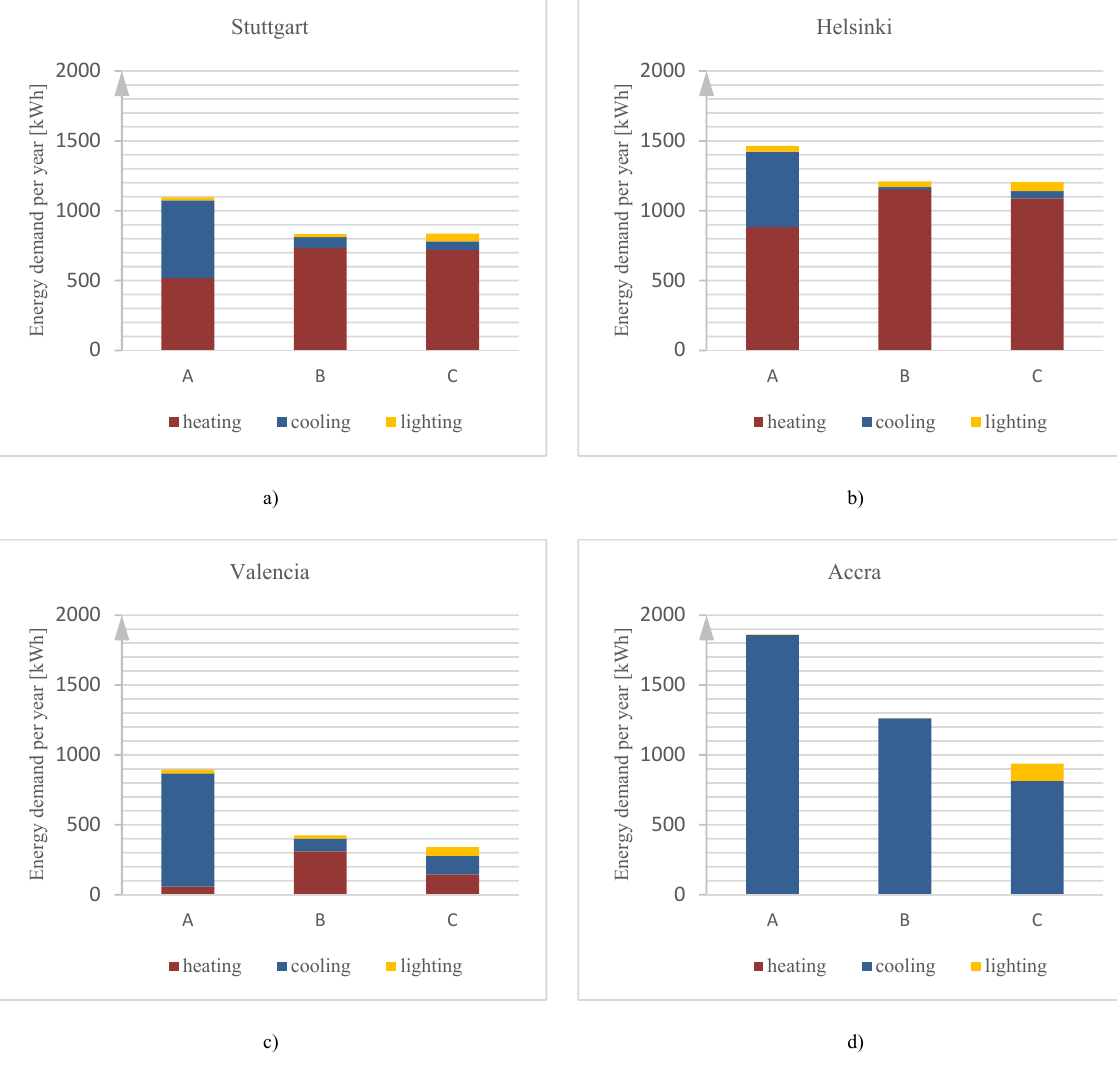
Fig. 7 Energy performance of a structured TN-glazing in comparison with reference glazing